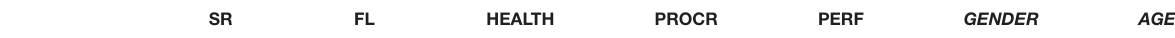
TABLE 5 | Standardized indirect effects (default